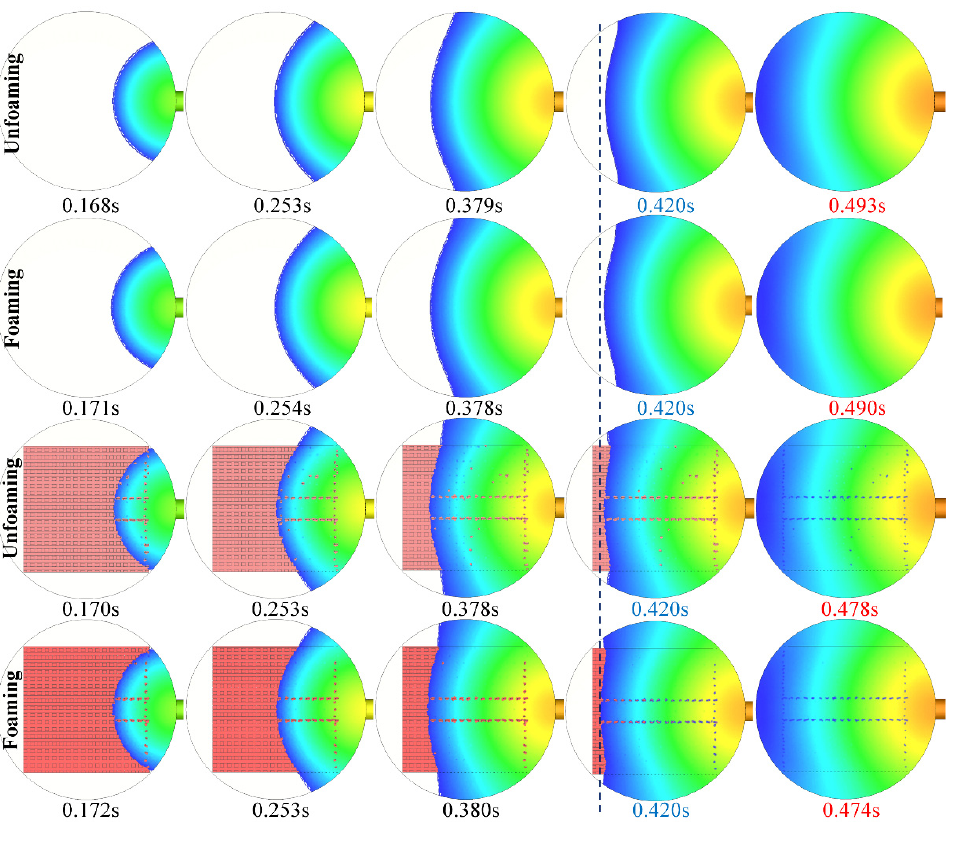
Figure 3. Numerically simulated conventional injection molding (unfoaming), microcellular injection molding (foaming), insert injection molding (unfoaming), and insert-microcellular injection molding (foaming). The numbers in red color are the total filling time of the mold cavity. The 0.420 s in blue color indicates an example for comparison of the filling melt front.